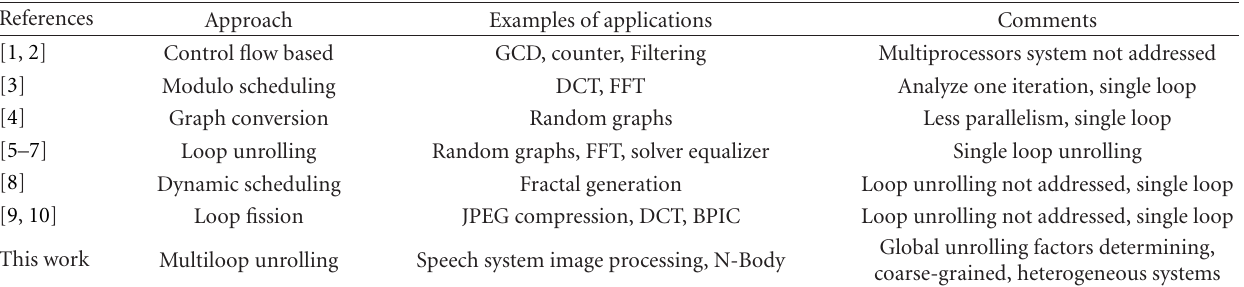
Table 1: Some approaches to address